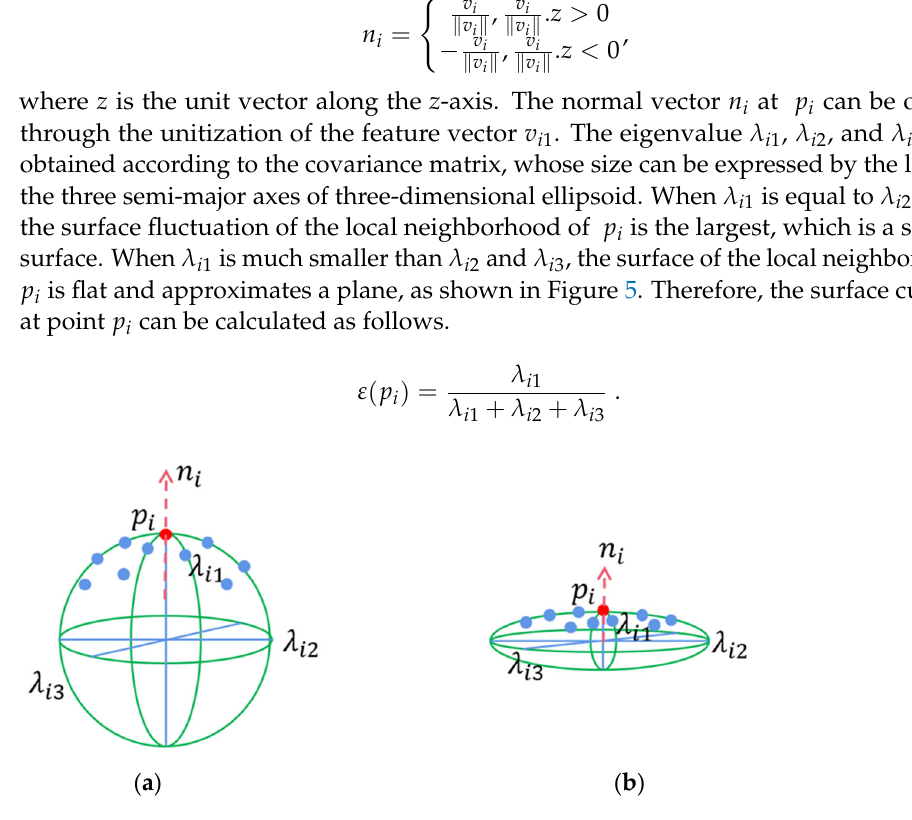
Figure 5. Surface fluctuation of local neighborhood. The red circle represents the current point 𝑝 (cid:3036) , and the blue circles represent the k neighbors around 𝑝 (cid:3036) : ( a ) When 𝜆 (cid:3036)(cid:2869) (cid:3404) 𝜆 (cid:3036)(cid:2870) (cid:3404) 𝜆 (cid:3036)(cid:2871) , the surface fluctuates the most; ( b ) when 𝜆 (cid:3036)(cid:2869) ≪ 𝜆 (cid:3036)(cid:2870) , 𝜆 (cid:3036)(cid:2869) ≪ 𝜆 (cid:3036)(cid:2871) , the surface is close to a plane.